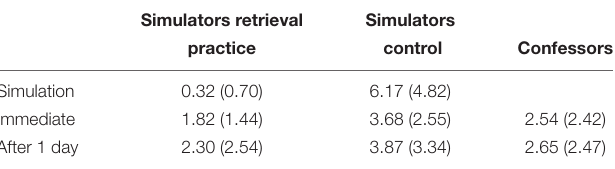
TABLE 3 | Total error scores provided by each group during the three memory tests (simulation vs. immediate vs. after 1